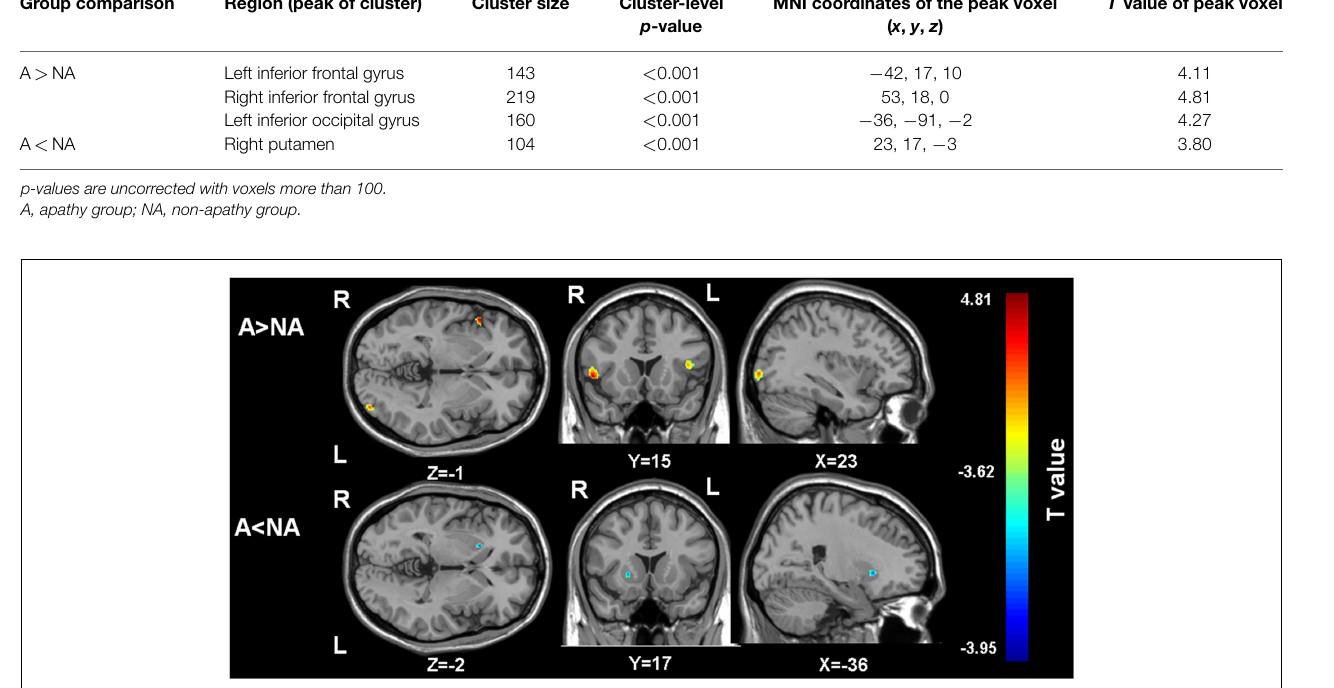
FIGURE 1 | The regions showing gray matter volume differences between the two groups . A, apathy group; NA, non-apathy group. (Threshold at p uncorrected < 0.001 and voxels more than 100). A > NA: the regions